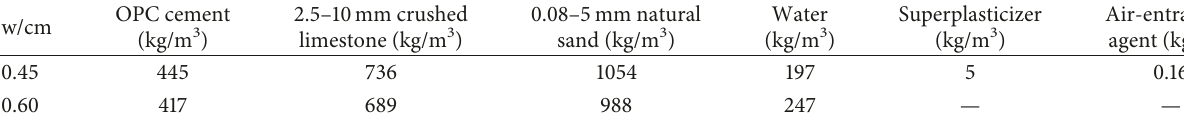
Table 1: Composition of the investigated concrete mixtures.